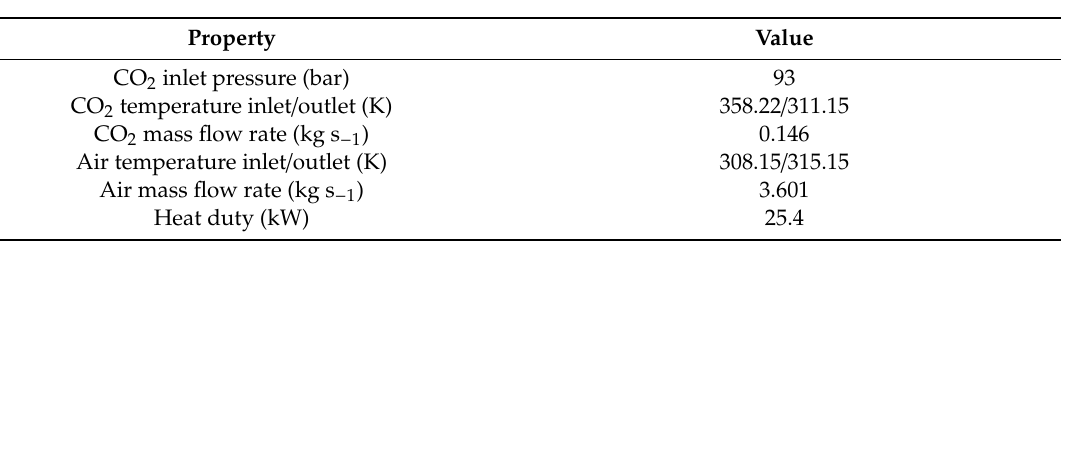
Table 1. On-design specifications of the gas